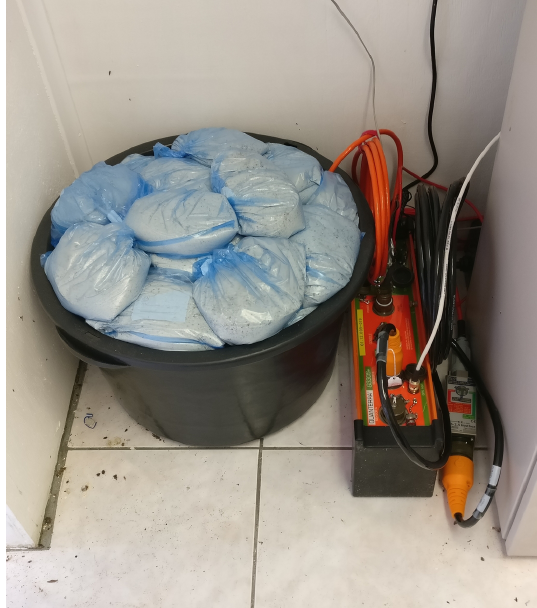
Figure 9. Seismic installation at station SABV. The seismometer rests on the tiles on the concrete floor and is completely surrounded by dry sand in a quasi-flexible container. Next to the sensor is the